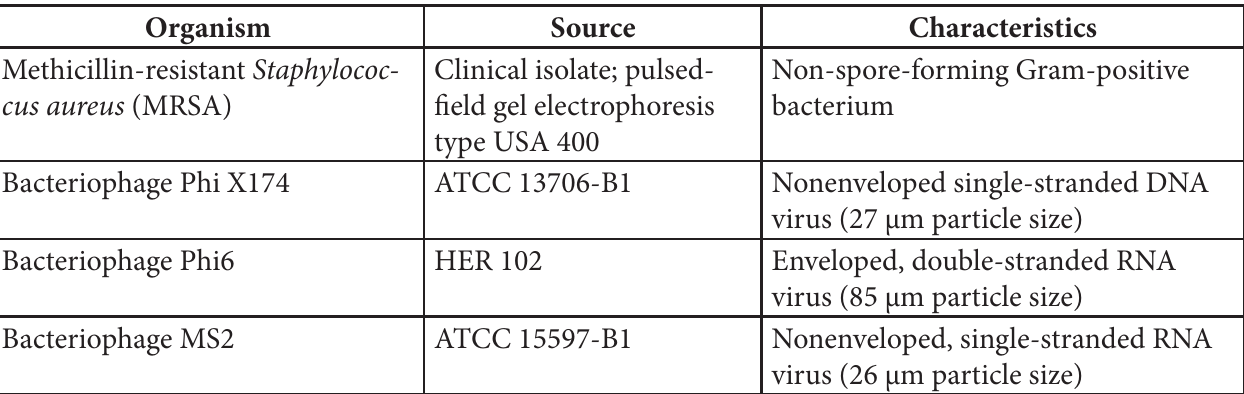
Table 1 . Characteristics of the test organisms